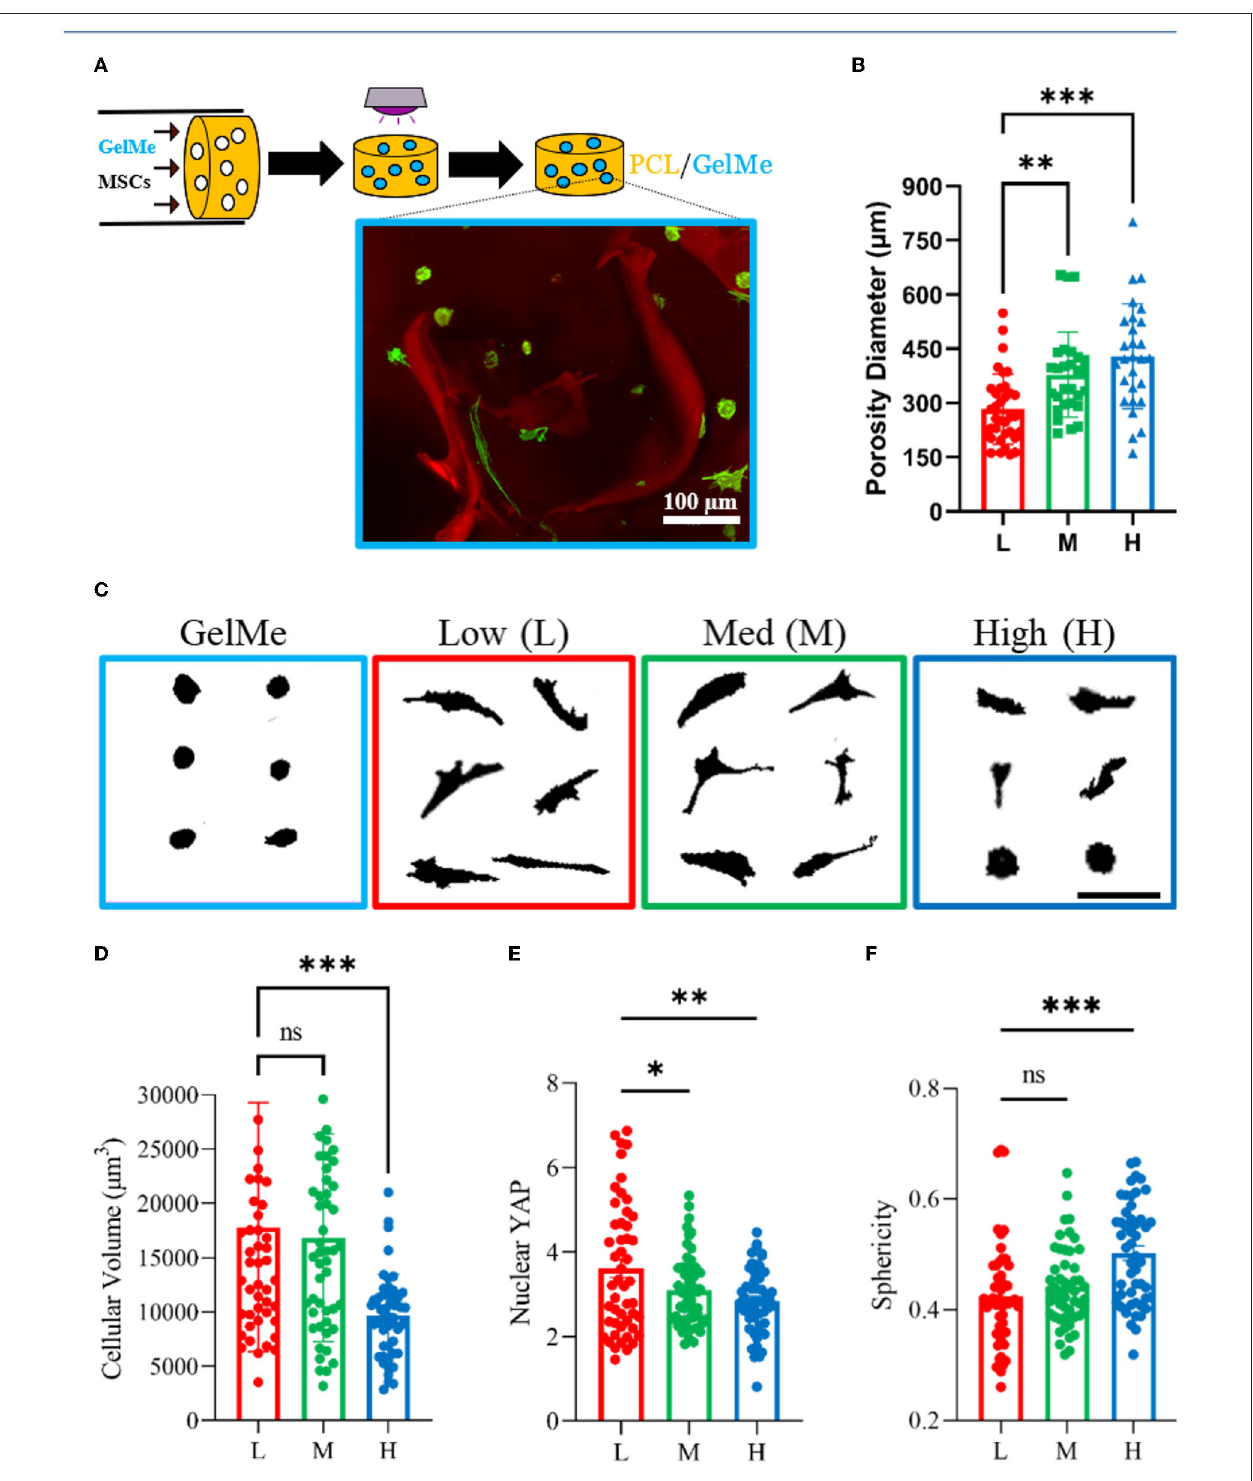
FIGURE 3 | Pore diameter affects MSC mechanosensing in porous scaffold-hydrogel composites. (A) Schematic of MSC-laden GelMe perfusion process and representative confocal image of encapsulated MSCs (green) interacting with proximal pores (red). (B) Quantification of pore diameters for Low (L), Med (M), and High (H) porosity scaffolds. (C) Representative single cell silhouettes of MSCs encapsulated in GelMe and in GelMe perfused into L, M, and H porosity scaffolds. Quantification of cellular (D) Volume, (E) Nuclear YAP, and (F) Sphericity of MSCs encapsulated in GelMe perfused into L, M, and H porosity scaffolds. Bar graphs represent the mean and points individual cells; n > 50 cells per group, ns, not significant, * p < 0.05, ** p < 0.01, *** p < 0.001. Scale bars: 100 µ m.